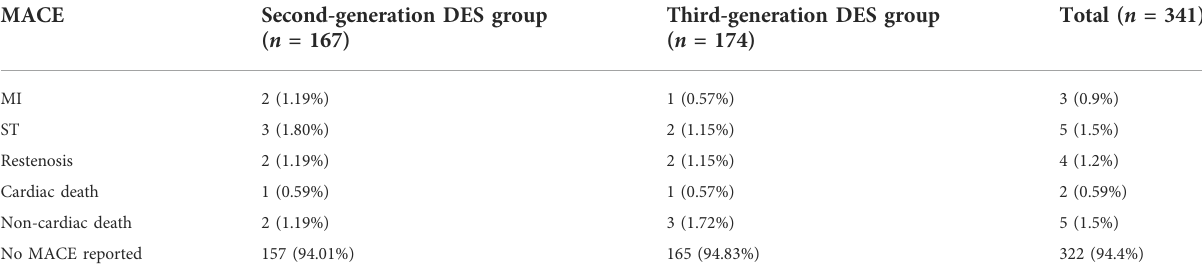
TABLE 4 Major adverse cardiovascular event distribution in the second- and third-generation DES. MACE Second-generation DES group ( n =